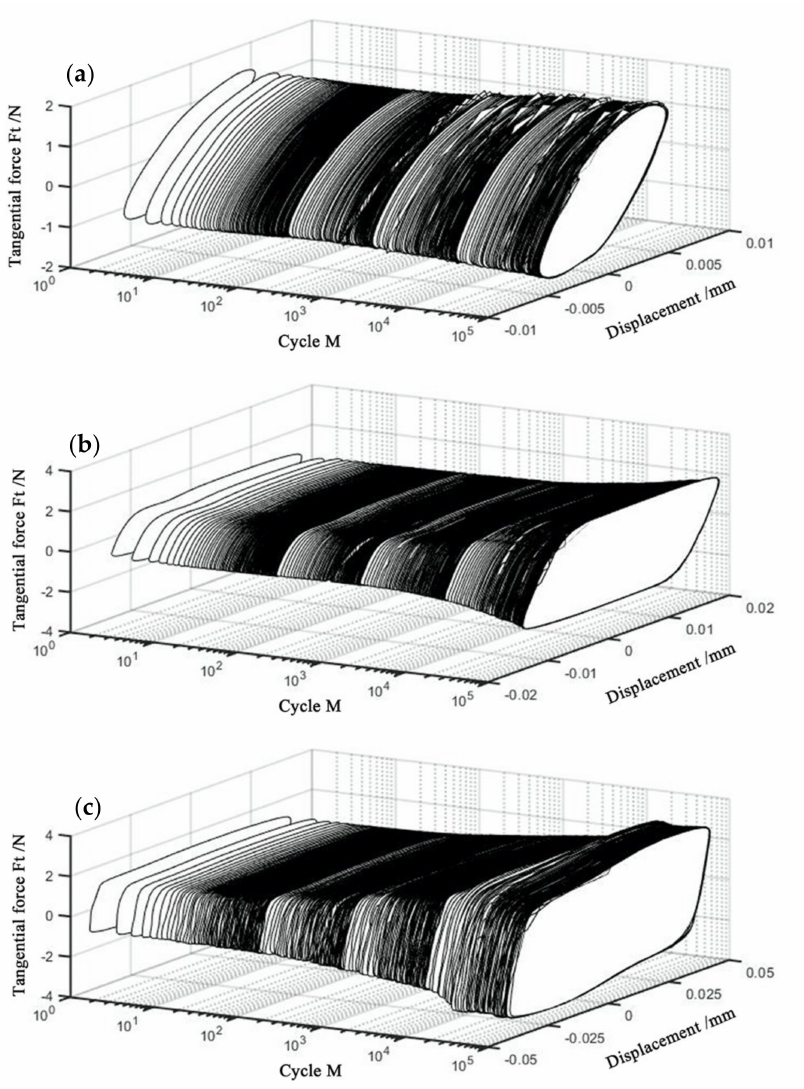
Figure 4. Curves of PVDF thin films with F n = 15 N, ƒ = 15 Hz, and V c = 0 V; ( a ) D = ± 5 µ m, ( b ) D = ± 15 µ m, and ( c ) D = ± 40 µ